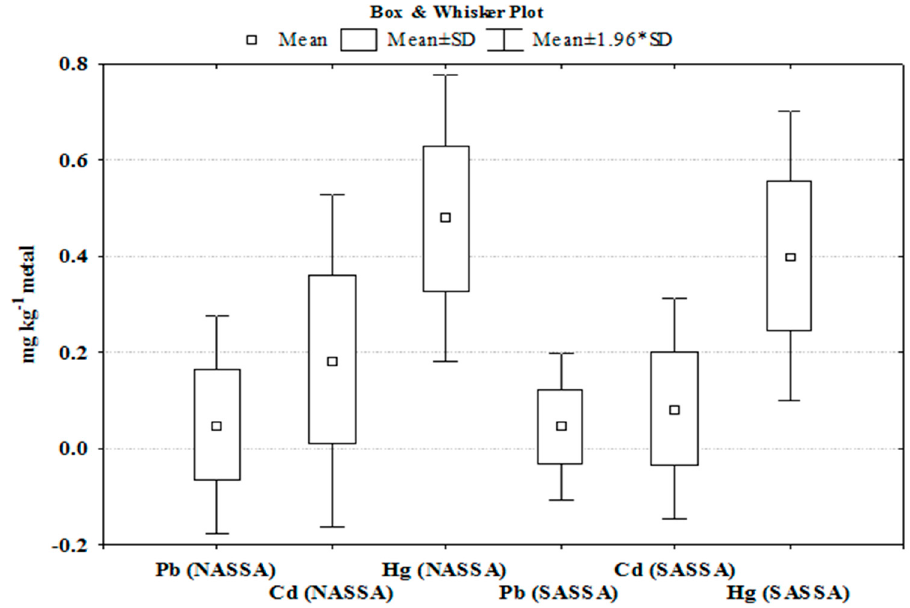
Figure 2. Graphical representation of box and whisker plots show data sets distribution of Hg, Cd and Pb levels in tested albacore tuna NASSA and SASSA samples. (*) corresponds to ± 1.96 times the SD. ± 1.96 times the category standard deviation (normal distribution of concentrations of each metal and